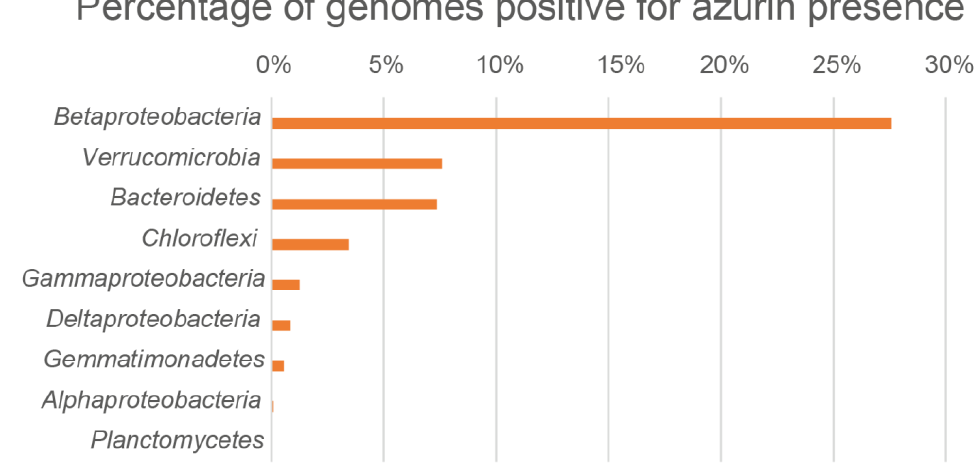
Figure 1. Percentage of genomes positive for azurin presence. The figure shows the percentage of genomes positive for azurin presence in each taxonomic group with at least one positive hit. Note that listed taxonomic groups have different rankings.